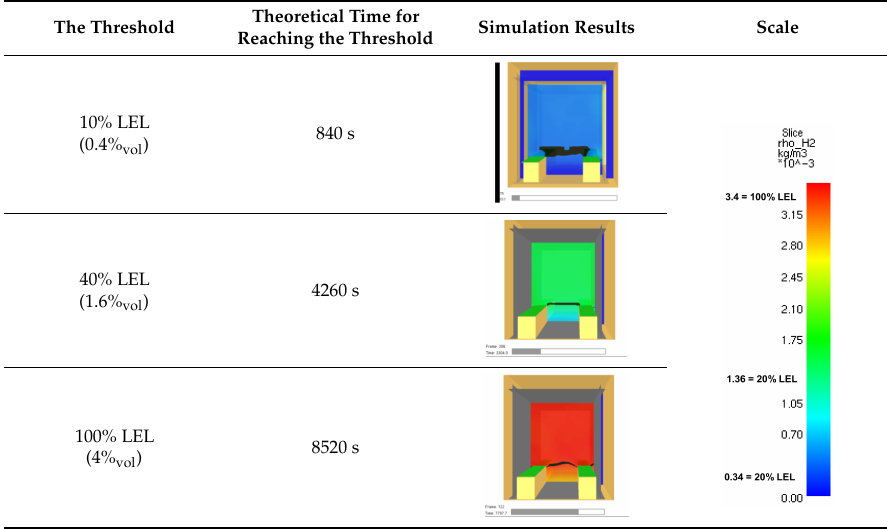
Table 3. Increase in the hydrogen concentration in the room without